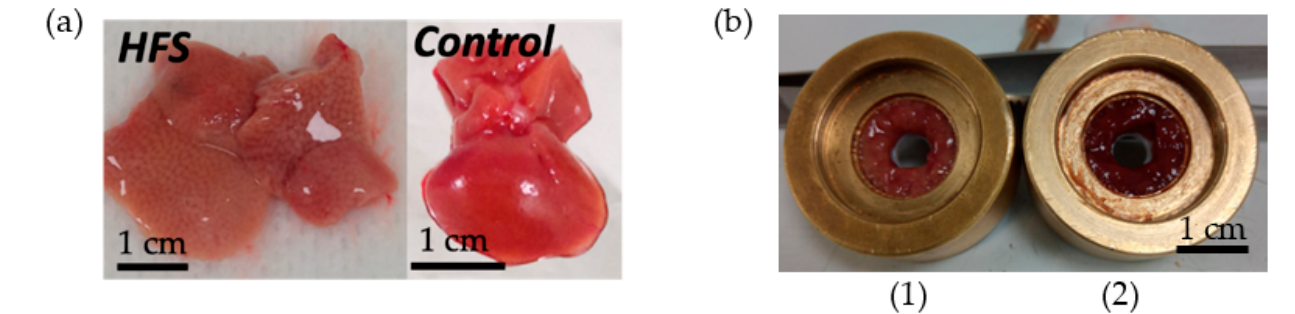
Figure 4. Ex vivo mice liver samples. ( a ) An HFS Diet liver sample and control diet liver sample. ( b ) Samples of liver in the sample holder (0.32 cm 3 ): on the left HFS Diet liver (1) and on the right control Diet liver (2).